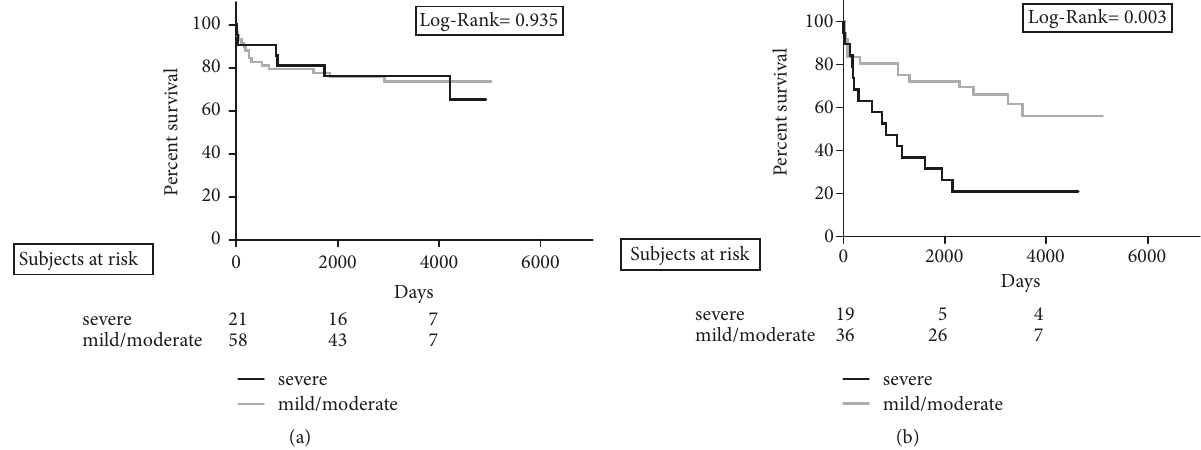
Figure 4: Cumulative overall graft survival rate according to graft histological ischemia/reperfusion injury severity in recipients with HCV unrelated (a) and HCV-related (b) liver